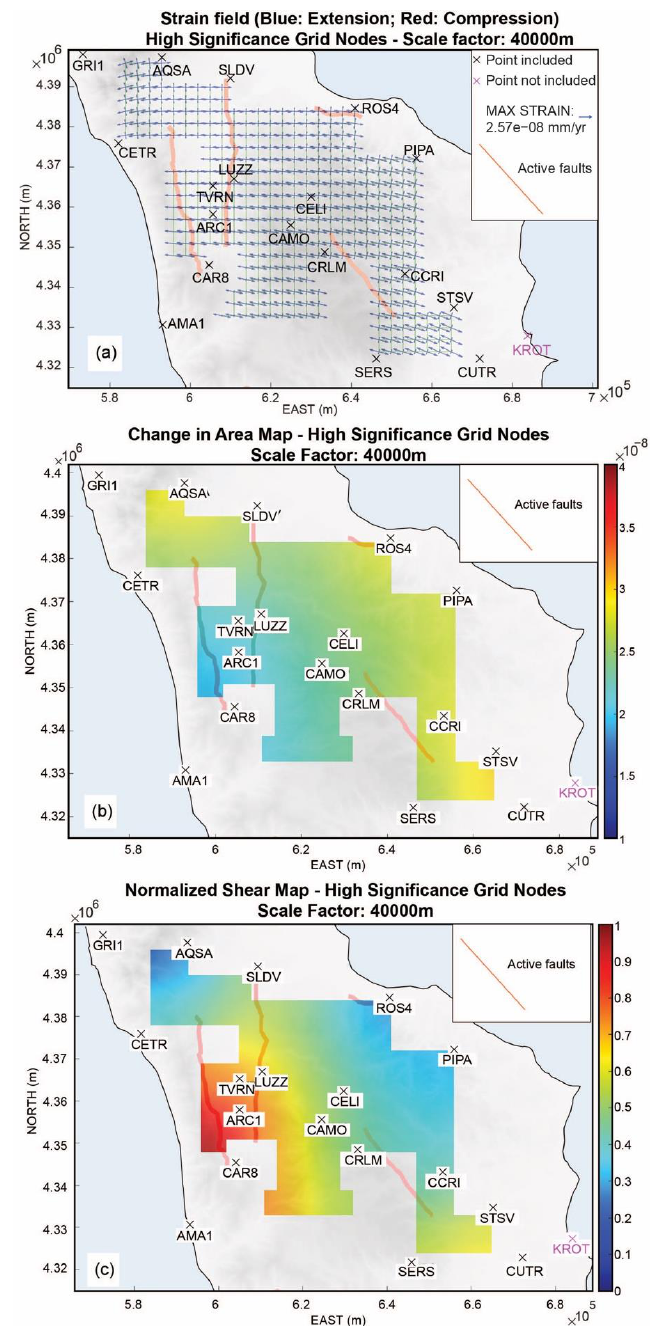
Figure 8. ( a ) Principal strain-rate axes, computed in the grid nodes characterized by high geometric significance; ( b ) map of the field of change in area (i.e., the trace of the strain-rate tensor); ( c ) map of the field of engineering shear normalized to the change in area. The strain-rate field is also shown in Figure S13 (Supplementary Material), where the data related to mid significance nodes are also shown.